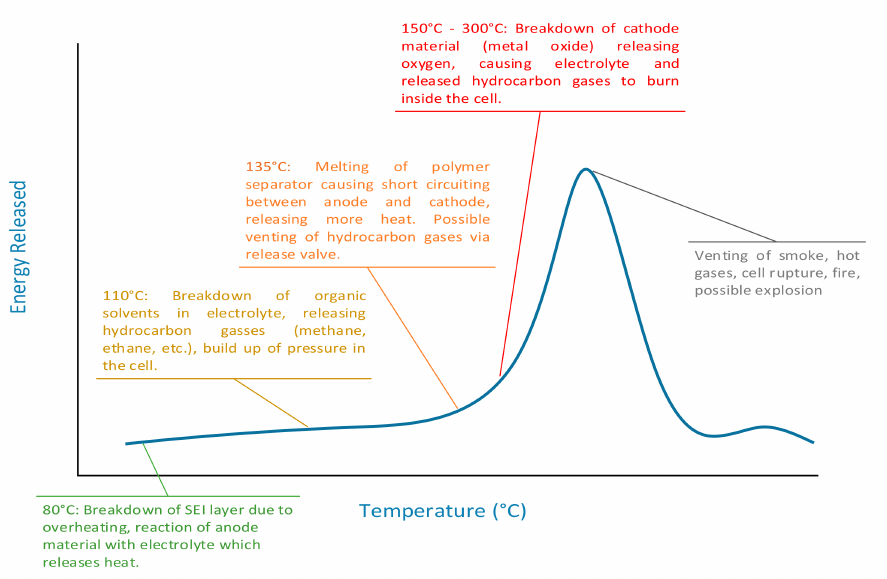
Figure 5. Thermal Runaway, Sequence of